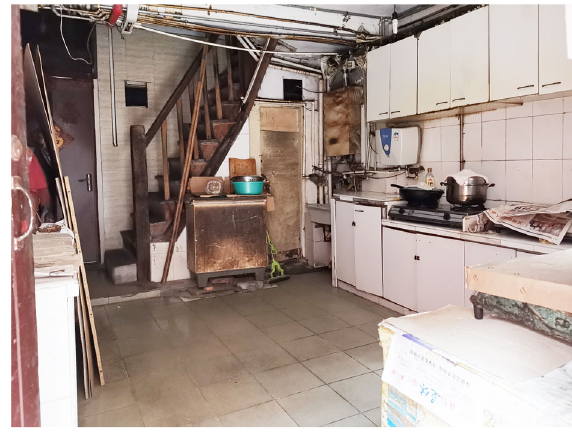
Fig. 7 There are newly added elements on the façades, such as equipment for fire safety and the white sewage outlets (Source: Kaiyi Zhu,